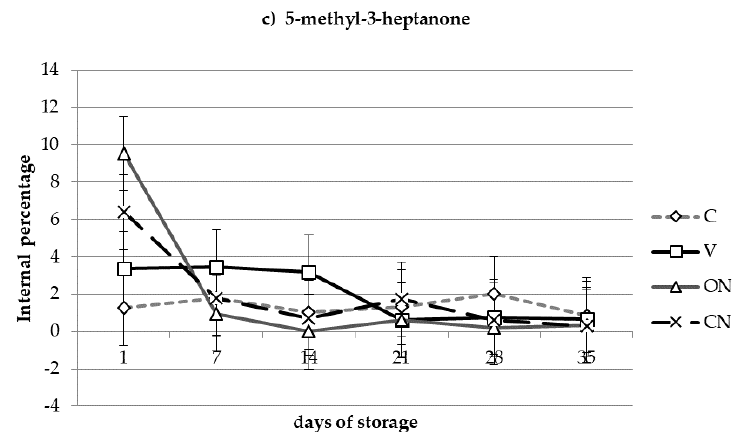
Figure 2. Trend of ethyl methylbutanoate (compound no. 2 in Table 1) ( a ); 1-octen-3-ol (no. 5) ( b ); and 5-methyl-3-eptanone (no. 6) ( c ) during the storage. C: atmospheric pressure (control), V: hypobaric packaging at 30 kPa, ON: 1% O 2 /99% N 2 , CN: 40% CO 2 /60% N 2 . Bars indicate the standard deviation.